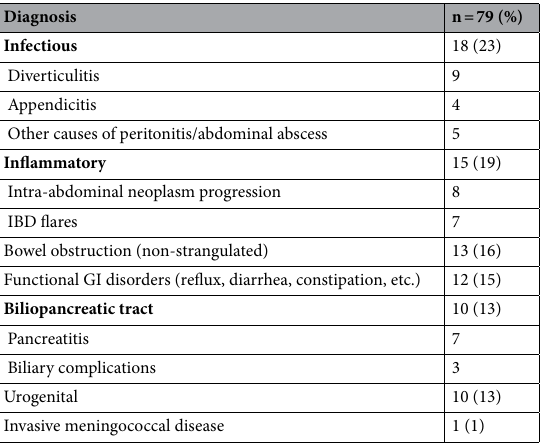
Table 2. Etiological diagnosis of the control group with acute abdominal pain. Abbreviations: IBD inflammatory bowel disease, GI gastro-intestinal.